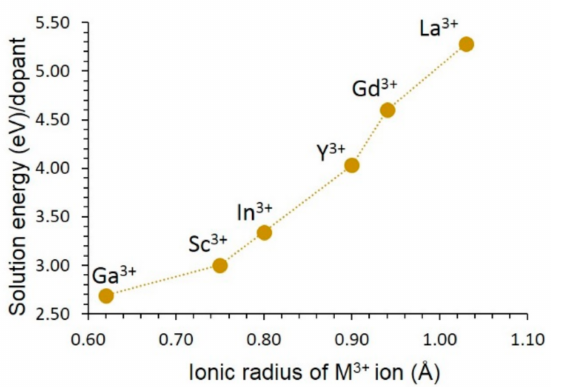
Figure 6. Solution energy of M 2 O 3 (M = Ga, Sc, In, Y, Gd, and La) with respect to the M 3+ ionic radius (charge compensation: Fe interstitial according to Equation (17)).